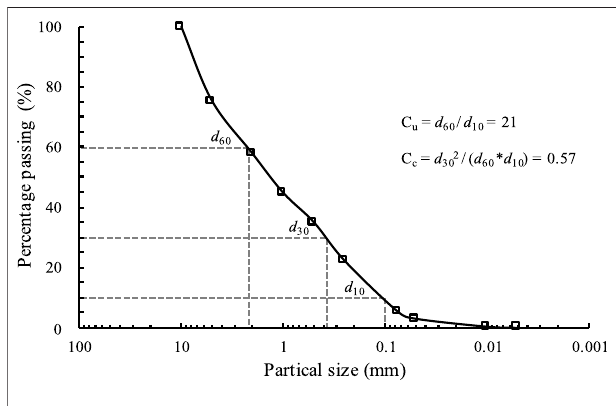
FIGURE 3 | Particle size distributions of glacial till samples.